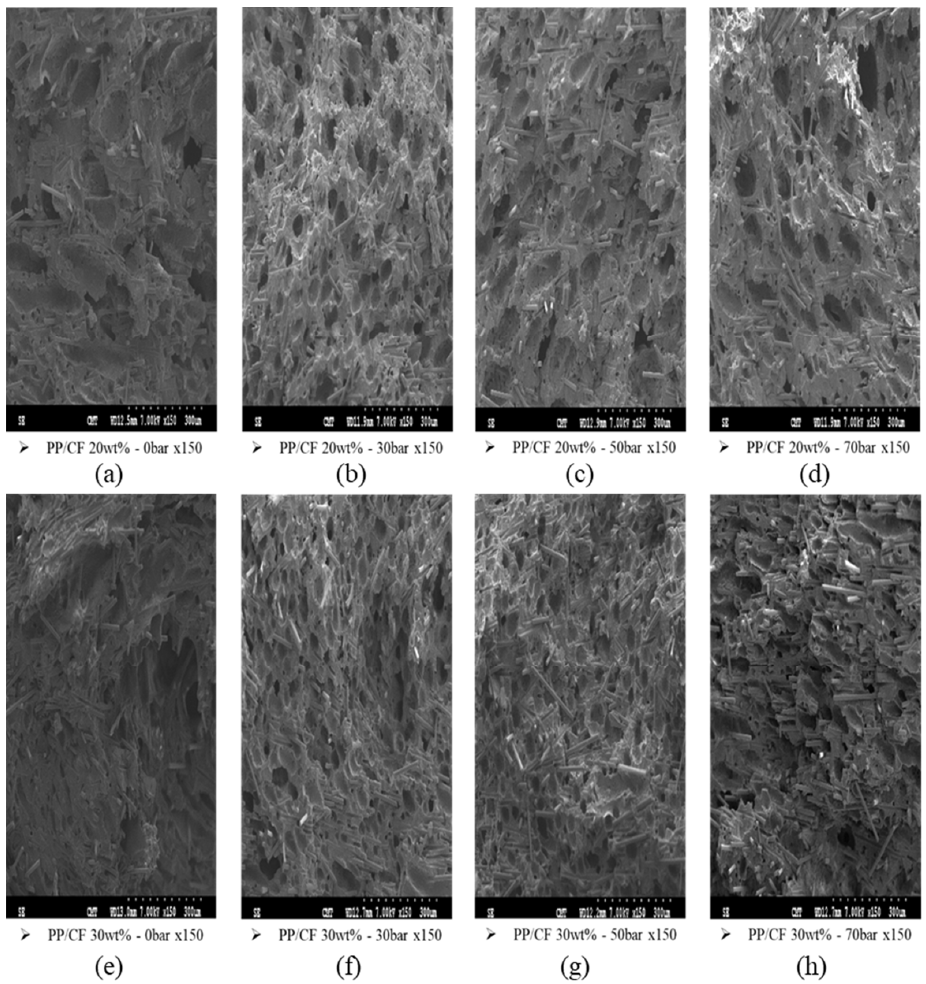
Figure 9. Fiber orientations in SCF-foamed PP composite with different GCPs: ( a ) PP/CF 20 wt%,